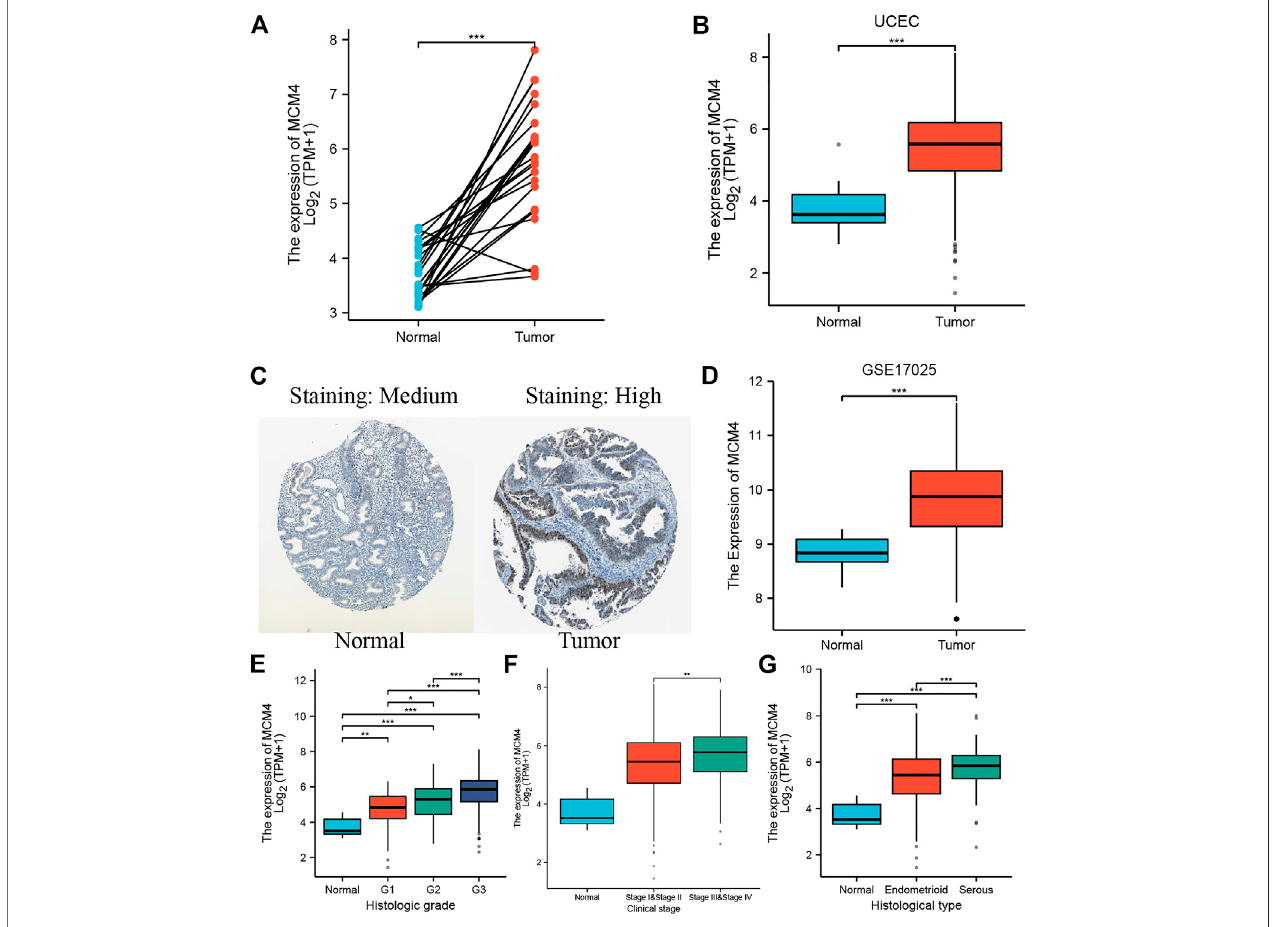
FIGURE 2 | MCM4 expression in UCEC tissues. (A) The expression level of MCM4 in paired normal and UCEC samples; (B) Differential expression of MCM4 in UCEC tissues from TCGA; (C) The Expression of MCM4 in UCEC in protein level (The Human Protein Atlas). MCM4 was signi fi cantly upregulated in UCEC tissues compared with normal tissues; (D) Differential expression of MCM4 in UCEC tissues from GSE17025; (E) MCM4 expression associated with higher grade, (F) higher stage,and (G) histologicaltype.*:p-value < 0.05;**:p-value < 0.01;***:p-value < 0.001.UCEC,uterinecorpusendometrialcarcinoma;TCGA,thecancergenome